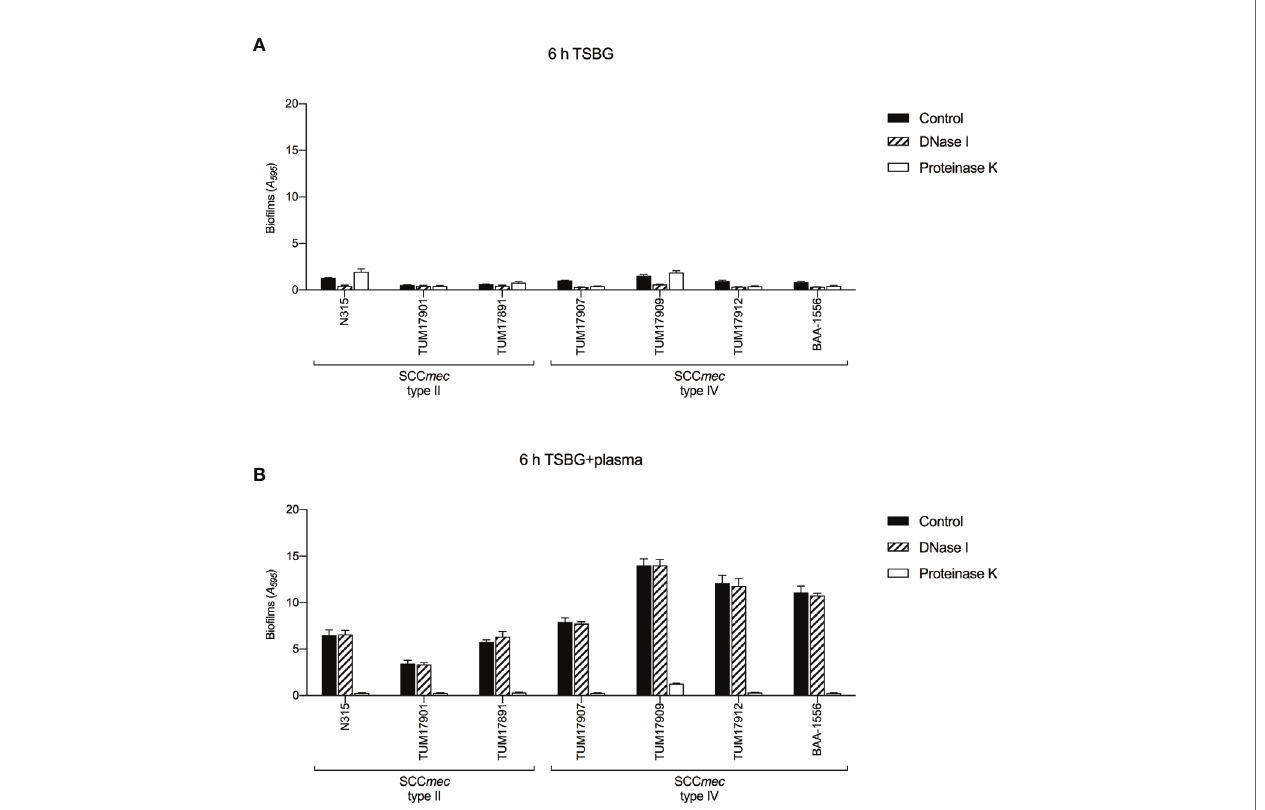
FIGURE 4 | Bio fi lm formation tests in the presence of extracellular matrix (ECM)-degrading agents. Bio fi lm formation was measured by crystal violet staining assay. (A) The effect of DNase I and proteinase K on bio fi lm formation in the absence of plasma. (B) The effect of DNase I and proteinase K on bio fi lm formation in the presence of plasma. Three wells were used for each strain per experiment, and the experiment was conducted twice. Data from the total of six experiments were compared between strains. TSBG, tryptic soy broth containing 0.5% glucose; Control, bio fi lm without